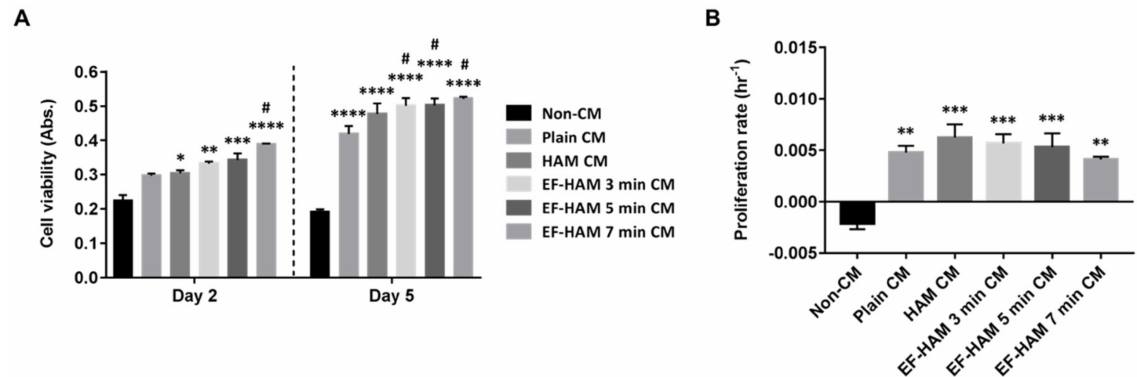
Figure 4. HUVECs grown in different EF-HAM CM showed higher viability than those grown in plain CM. ( A ) HUVEC viability measured using the PrestoBlue assay on the 2nd and 5th days of culture. ( B ) The proliferation rate of HUVECs was enhanced in the presence of CM. Two-way and one-way ANOVA were performed as shown in Figure 4A,B, respectively, as statistical tests for means and the values are represented as mean ± SEM (* p < 0.05, ** p < 0.01, *** p < 0.001, or **** p < 0.0001, compared with non-CM control; # p < 0.05, compared with plain CM).